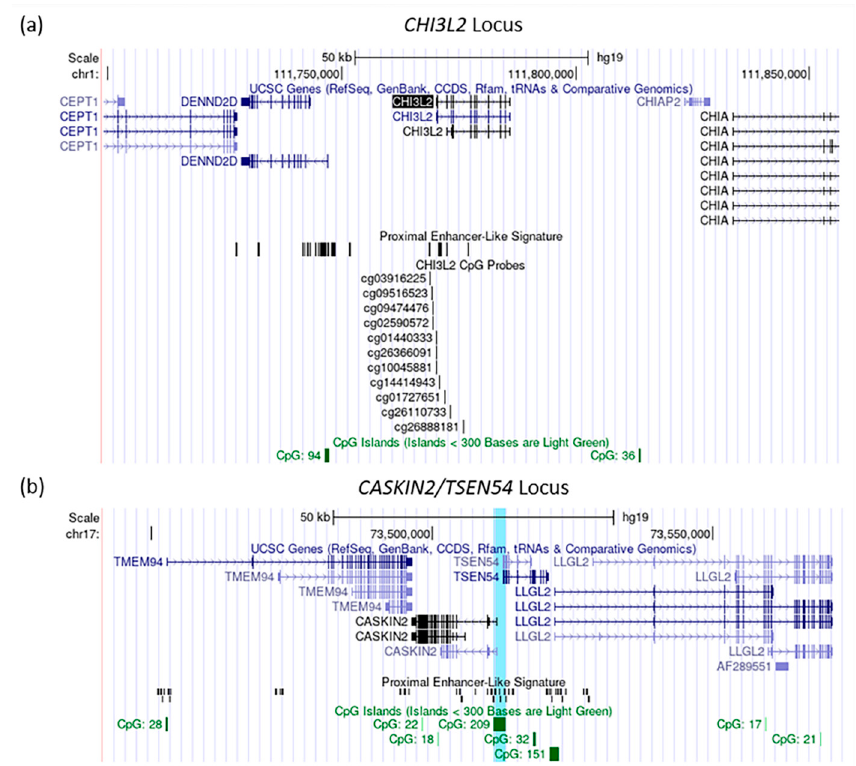
Figure 3. Genomic views of ( a ) CpG island sites across the CHI3L2 locus and flanking genomic regions ( b ) The vacancy surrounding CpG Island located at Chr17:73,511,016-73,513,176 (contains cg20442550 in Illumina 450K array). Highlighted in light blue the is location of the CpG island with 209 CG dinucleotide counts that had one probe differentially methylated between LOAD patients with vs. without depression. The CpG island is located between CASKIN2 and TSEN54. Images were made using the UCSC genome browser hg19/GRCh37 [32], and included the following tracks: Base position, UCSC Genes, CpG Islands, and ENCODE cCRE (Liftover was used to convert between CRCh38 and GRCh37).